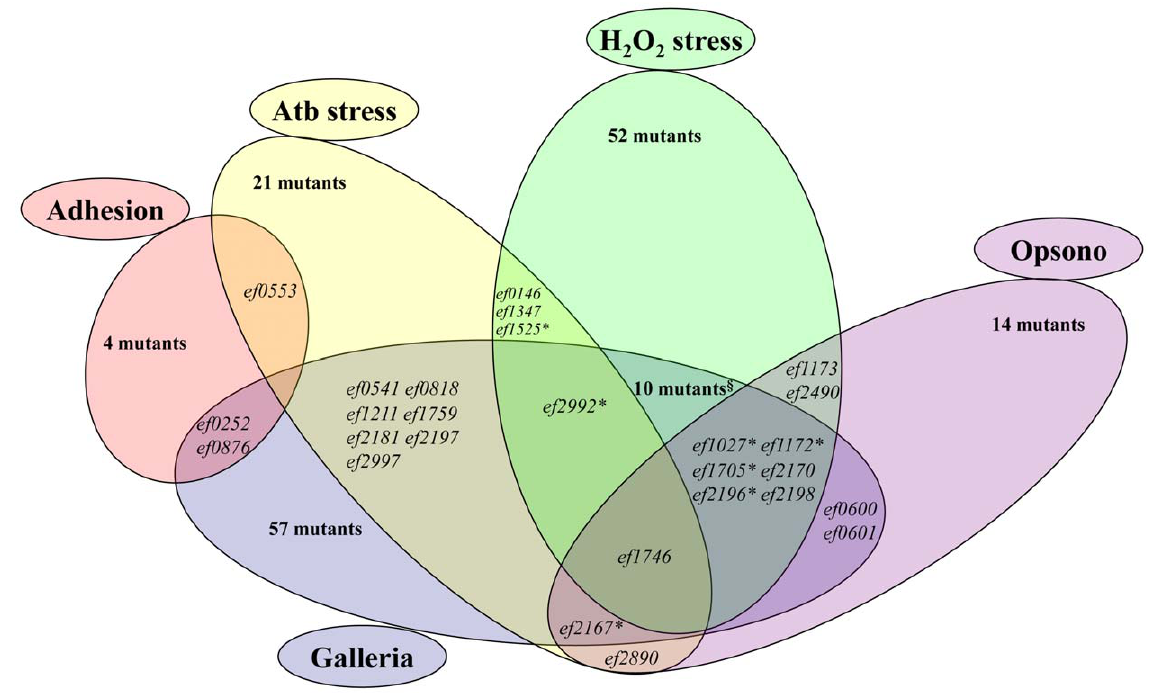
Figure 1. Venn diagram representation of the results of the five phenotypic tests performed on the mutants obtained in this study. Only genes that are common to at least two phenotypes are listed. The increased adhesion phenotype was not included due to difficulties in constructing the Venn diagram with these data. Stars indicate mutants with increased adhesion phenotype. 1 The 10 mutants combining phenotypes for H 2 O 2 stress and virulence are not shown due to lack of space in the figure. They were inactivated in ef0073 , ef0465 , ef0814 , ef1212 , ef1420 , ef1493 , ef1741 , ef1760 , ef1798 or ef2442 .